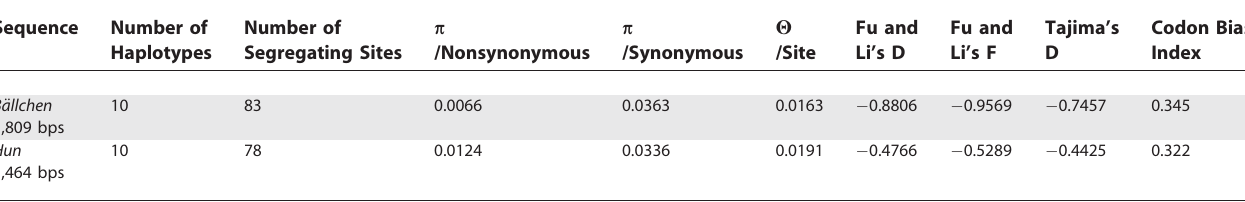
Table 1. Polymorphism Data for D. simulans Ba¨llchen and D. simulans Hun Sequence